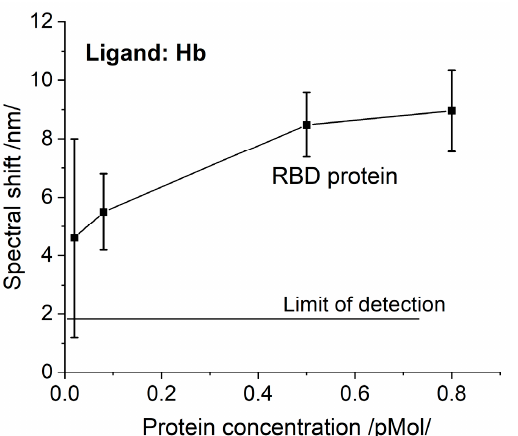
Figure 4. The spectral shift resulting from Hb/RBD interaction as a function of concentration.